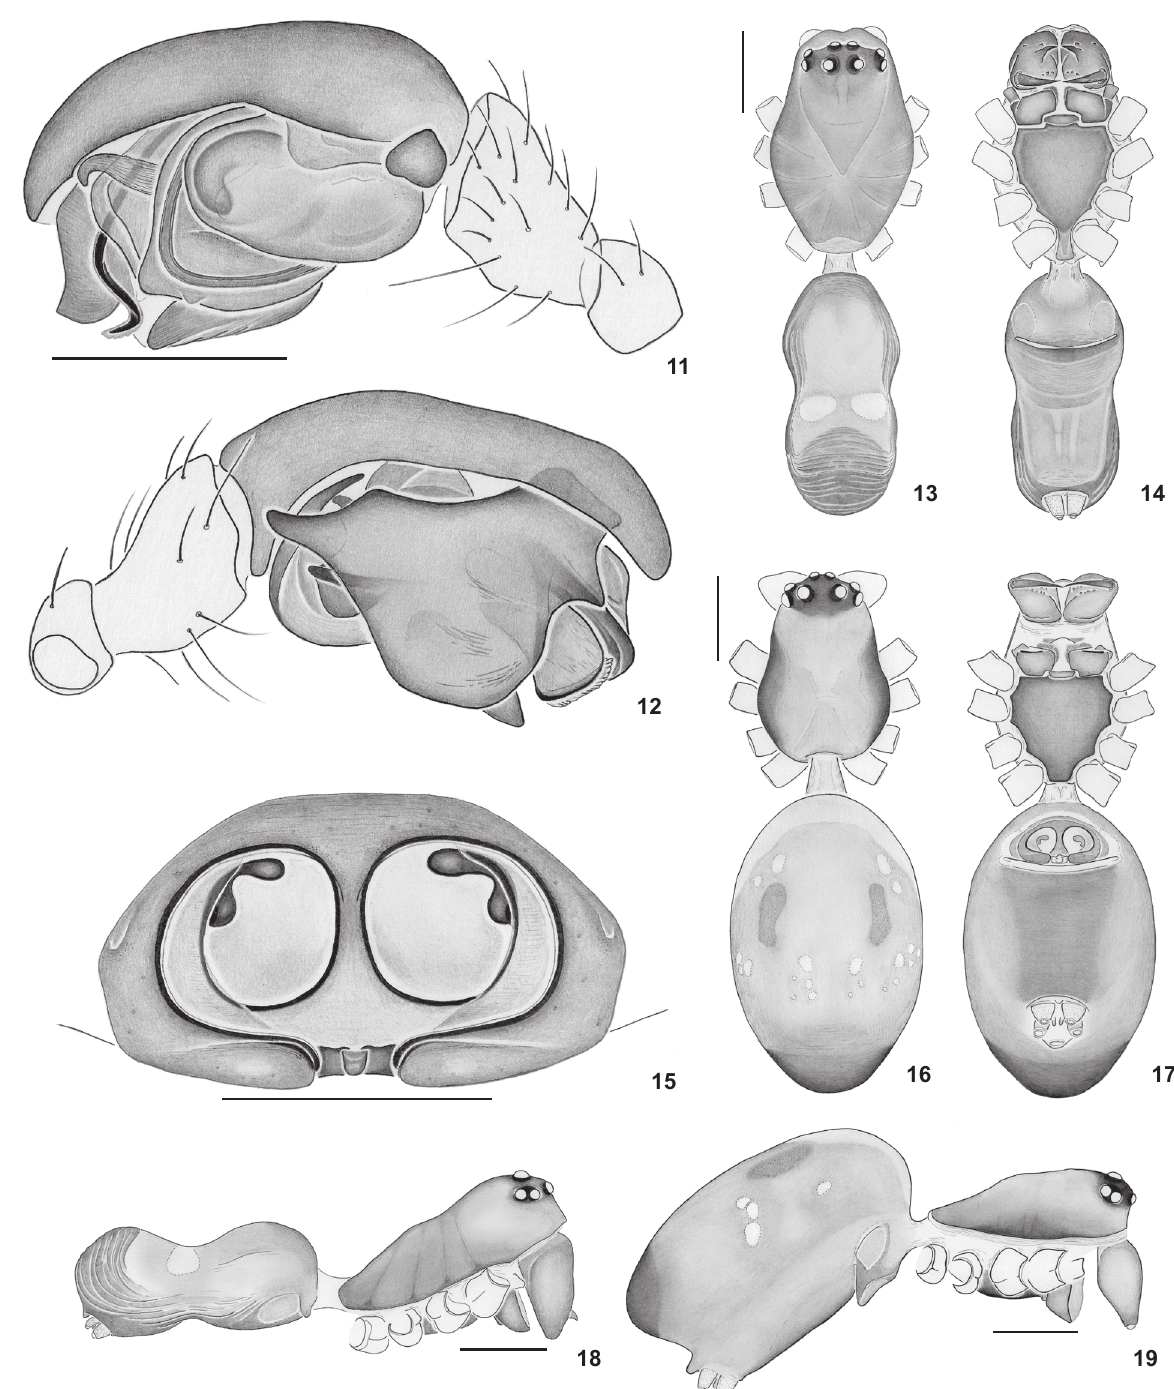
Figures 11-19. Eurymorion murici sp. nov. : (11-12) male palpus: (11) ectal view, (12) mesal view; (13-14, 18) male habitus: (13) dorsal view, (14) ventral view, (18) lateral view; (16-17, 19) female habitus: (16) dorsal view, (17) ventral view, (19) lateral view; (15) female epygine: (15) ventral view. Scale lines: (11-12 and 15) 0,25 mm, (13-14, 16-19) 0,5